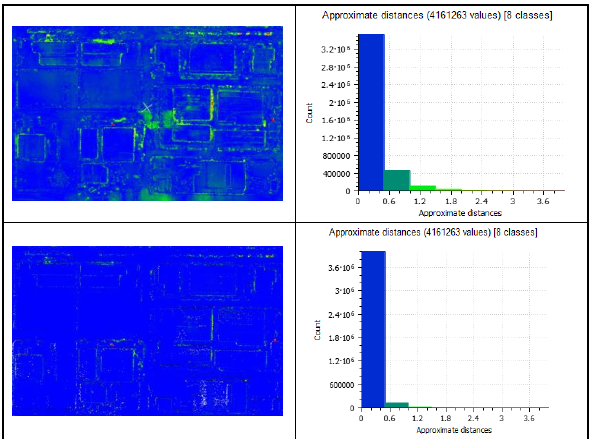
Figure 5. Error map which shows vertical distance between TIR and Visible point clouds after course (Top) and fine registration (Bottom). (Units are in meters) The average error of difference between them is 10, 12 and 20 in three axes. And the output point cloud density is 630 points per square meter.